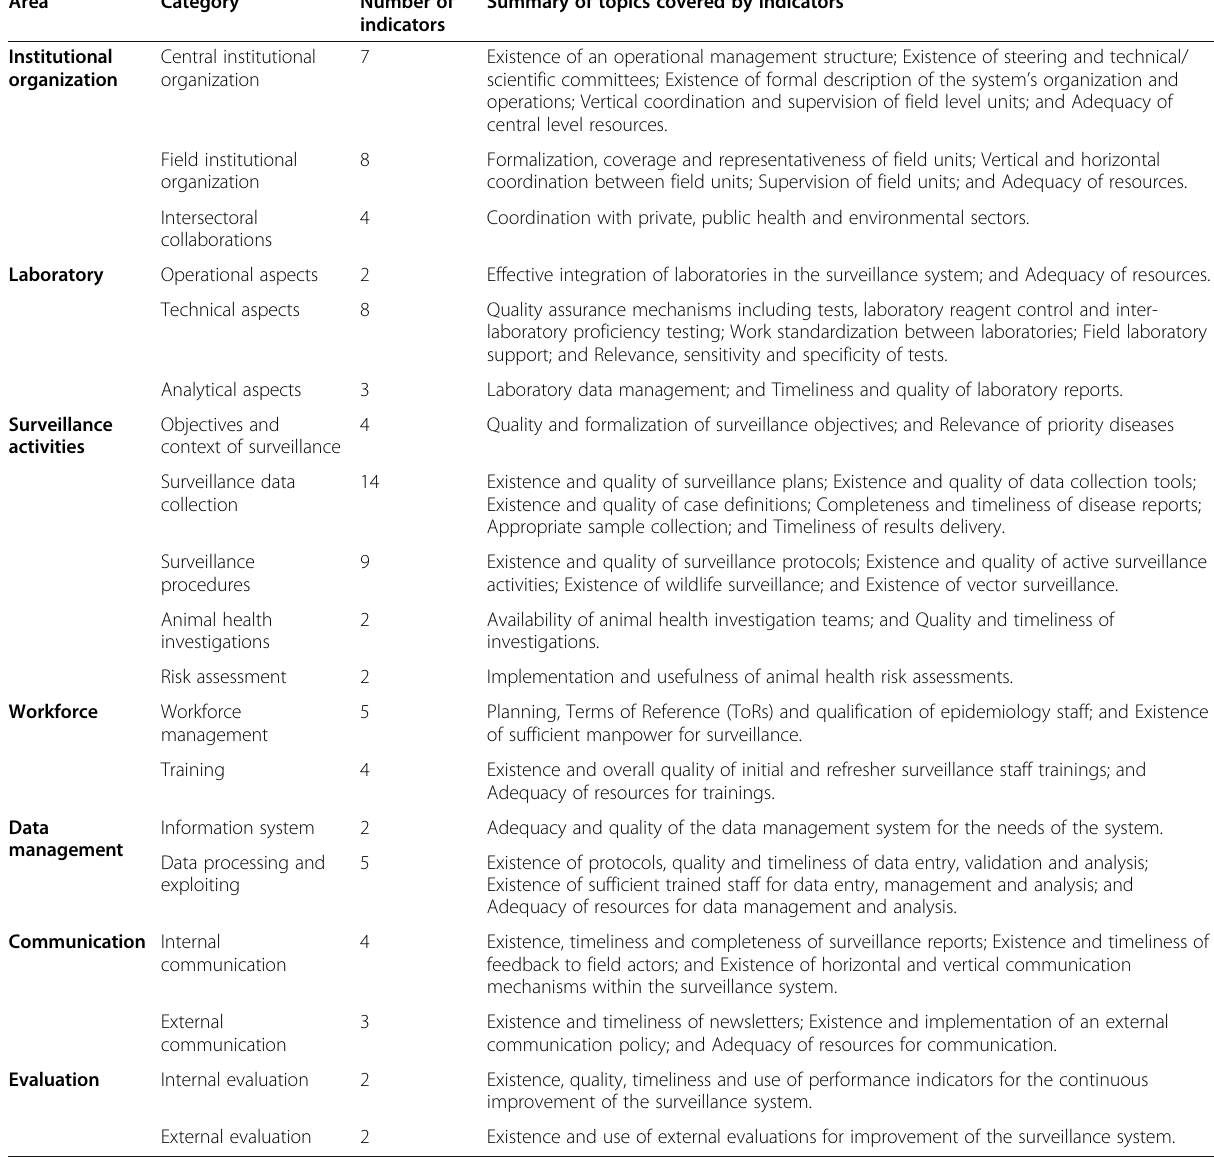
Table 1 Overview of SET areas, categories and